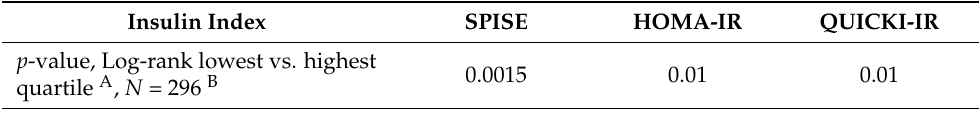
Figure 3. Longitudinal prediction of dysglycemia by SPISE. Ribbons around the survival curves represent the 95% confidence interval, and ticks represent right-censored data. Table 4. Longitudinal prediction of dysglycemia by SPISE score and established indexes of insulin resistance (Cox proportional hazard regression and log-rank test).